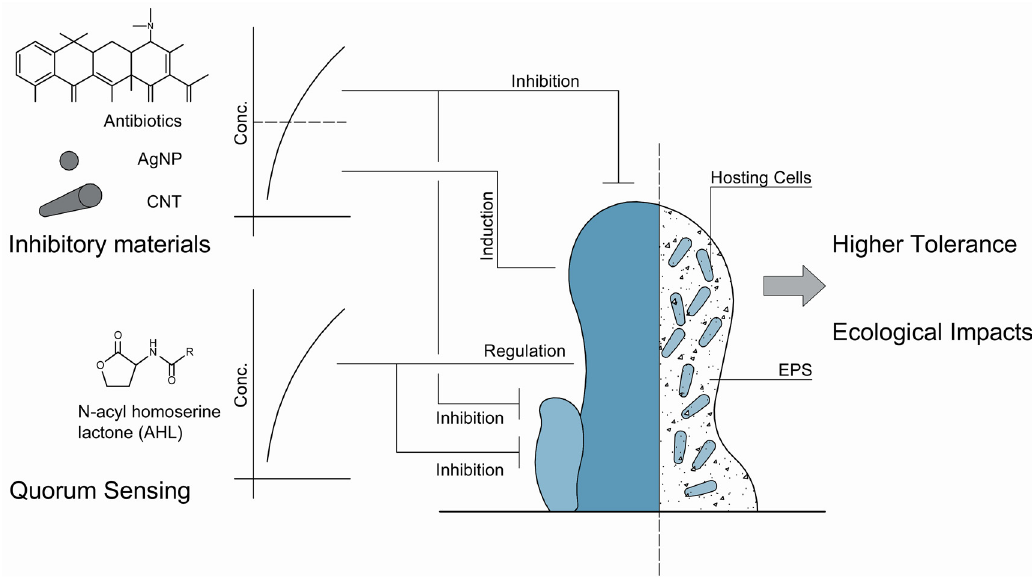
Figure 2. Biofilms in the presence of signals and stimuli in natural water systems, and the regulation and inhibition of these factors on biofilm matrix.